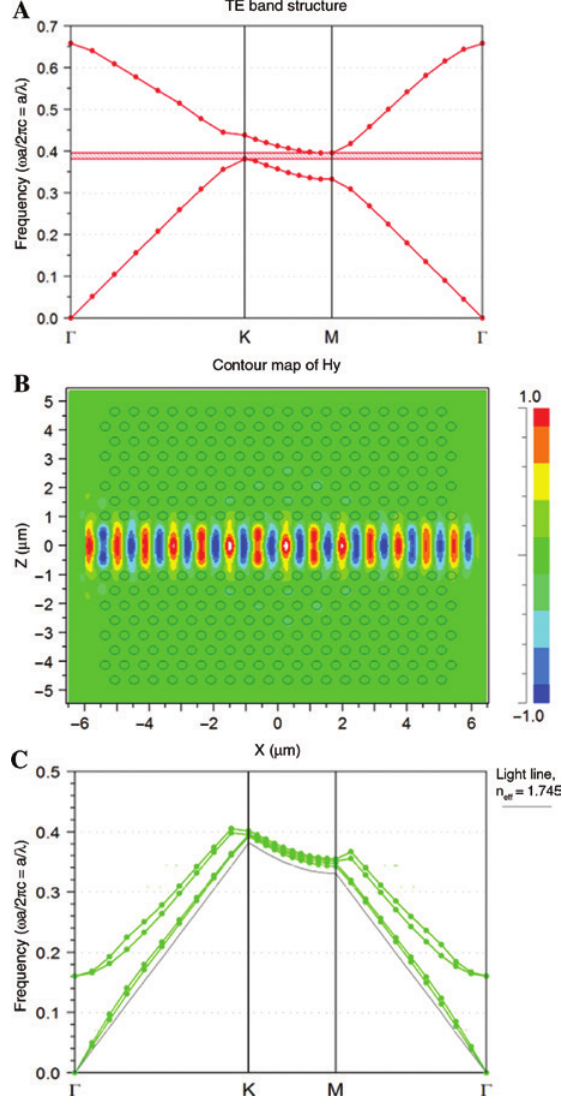
Figure 6: (A) TE band structure of the 2-D Er:ZnO PC, a PBG (red shadow region) appears ranging from 1510 nm to 1570 nm. (B) The steady-state field distribution for 1540 nm. (C) Band structure of the Er:ZnO